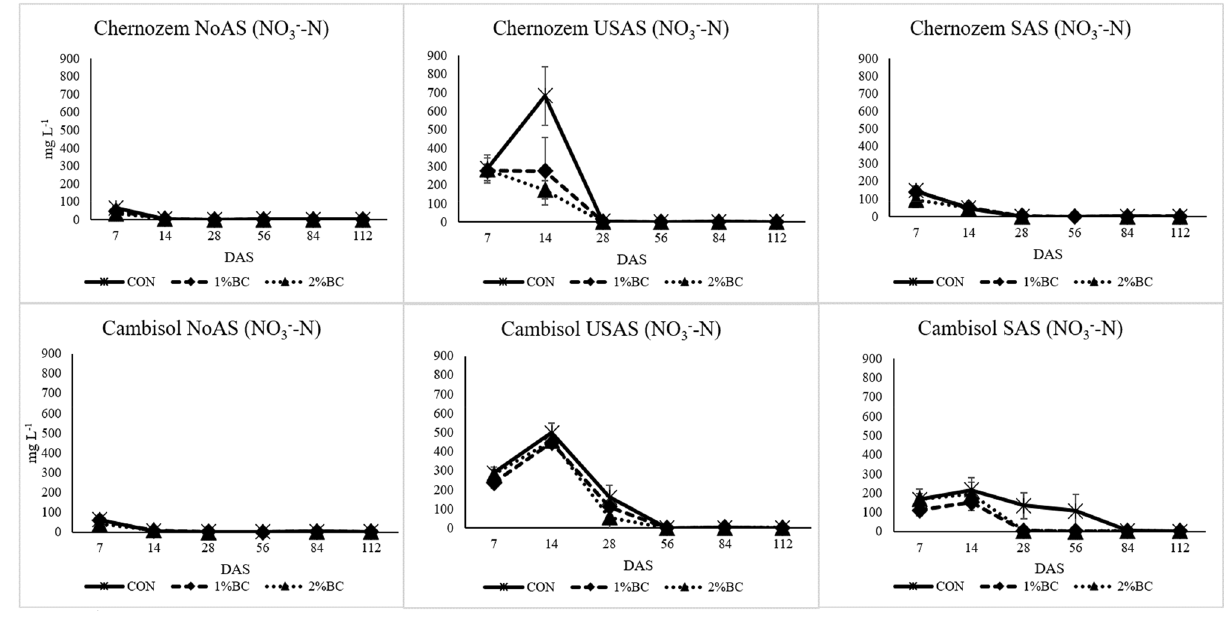
Figure 4. The effect of biochar, USAS (un-stabilized ammonium sulphate) and SAS (stabilized ammonium sulphate with DMPP) on the concentration of NO 3 − –N (mg L −1 ) in soil solution. NoAS No ammonium sulphate,